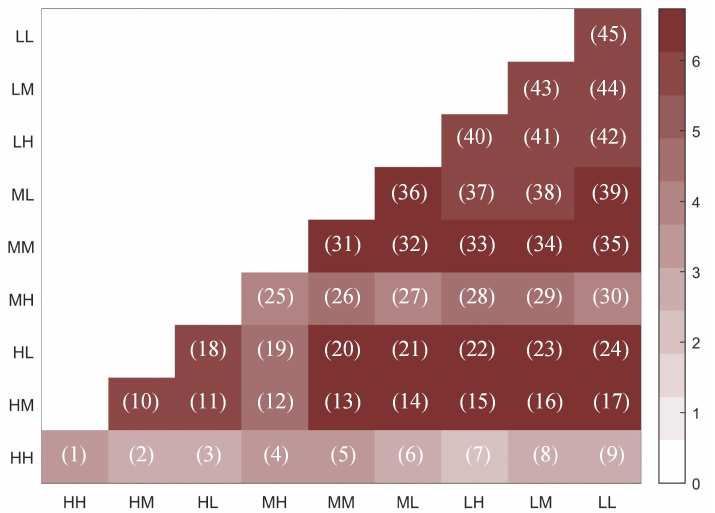
Figure 8. Correspondence between initial state and test case serial number (the horizontal coordinate represents the initial state of the first interceptor, while the vertical coordinate represents the second interceptor. The letters M, H, and L in the first position represent 44 km, 35 km, and 26 km altitude, respectively. The letters M, H, and L in the second position represent 1500 m/s, 1250 m/s, and 1000 m/s velocities,